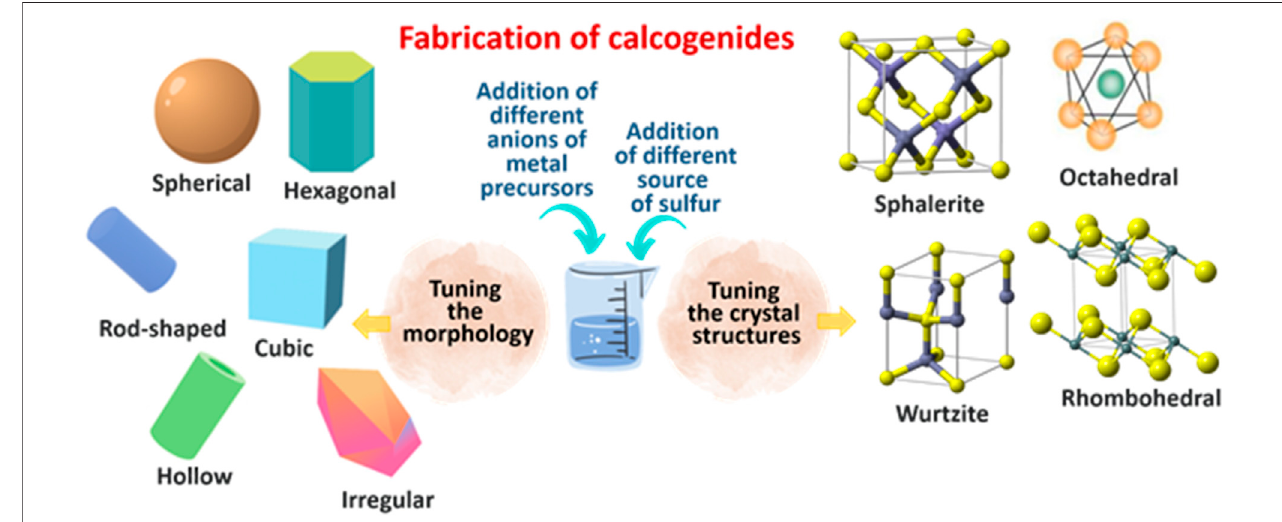
FIGURE 3 | Different morphologies and crystal structures of chalcogenides synthesized using different anion metal precursors and different sources of sulfur.